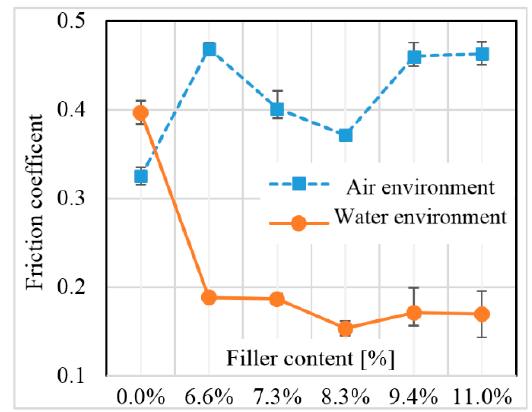
Figure 13. Influence of composite reinforcement on the kinematic friction coefficient in various environments.